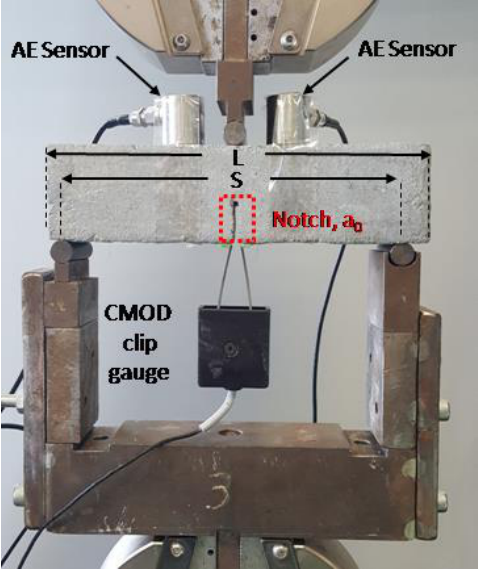
Figure 2. Configuration of the fracture energy test set-up.